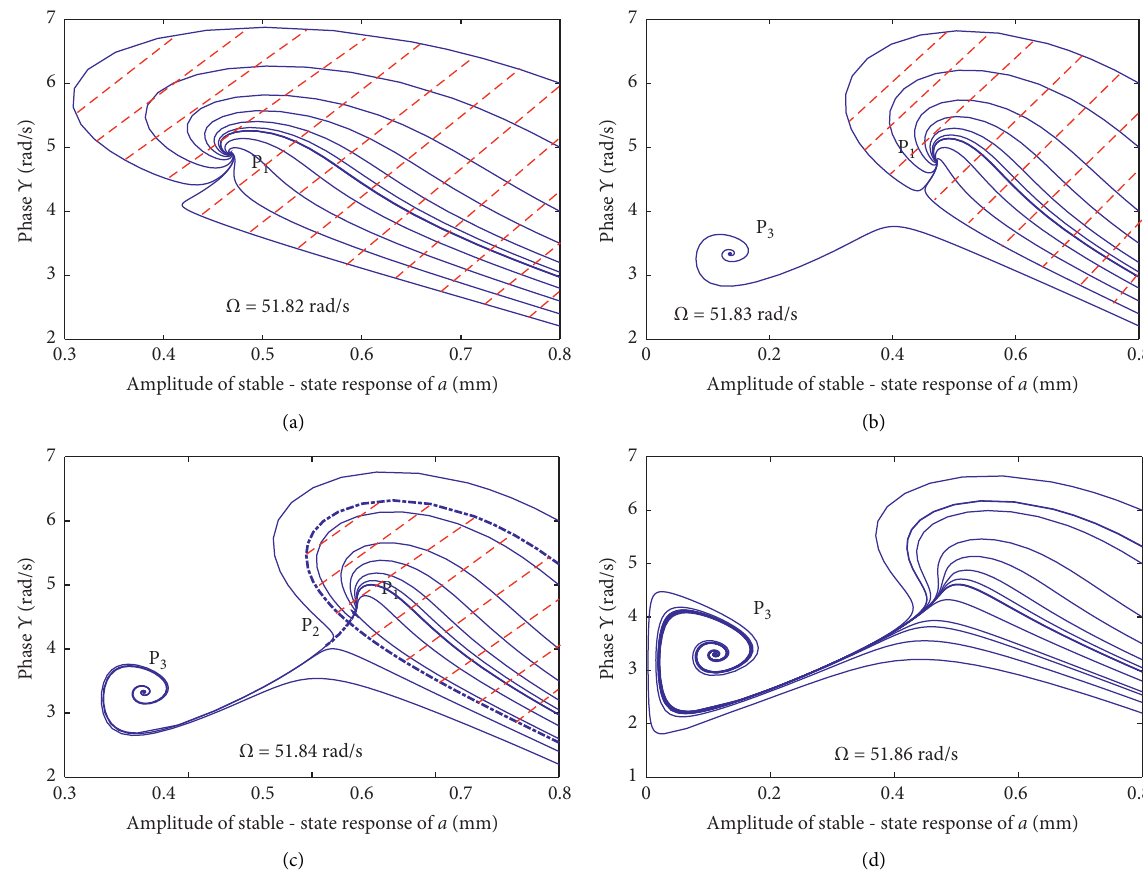
Figure 7: Variations of phase diagrams for different excitation frequencies: (a) 51.82rad/s, (b) 51.83rad/s, (c) 51.84rad/s, and (d)